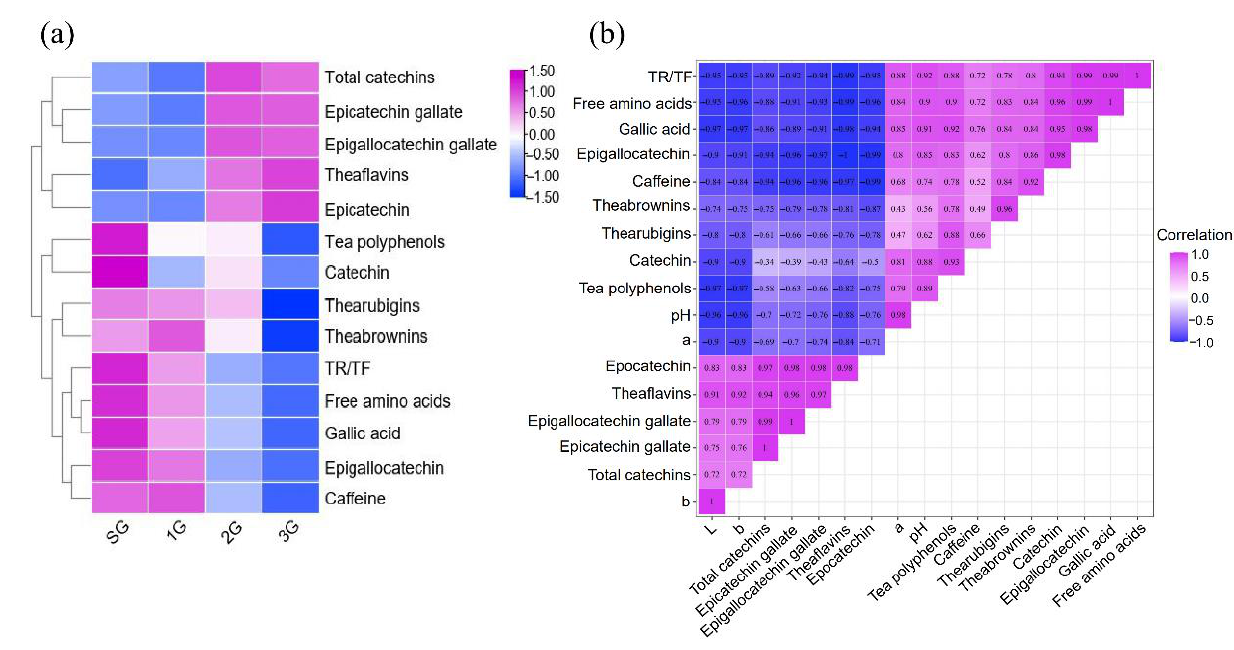
Figure 3. ( a ) Heatmap of the biochemical components in different grades of PCT. ( b ) Heat map based on the correlation analysis of compounds in PCT.